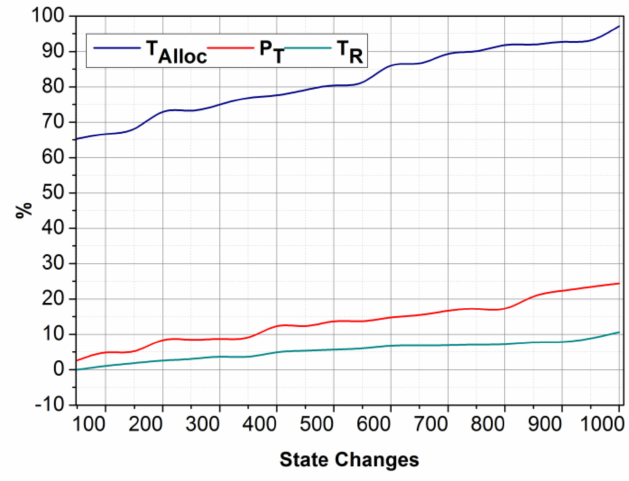
Figure 8. Analysis of T Alloc , P T , and T R